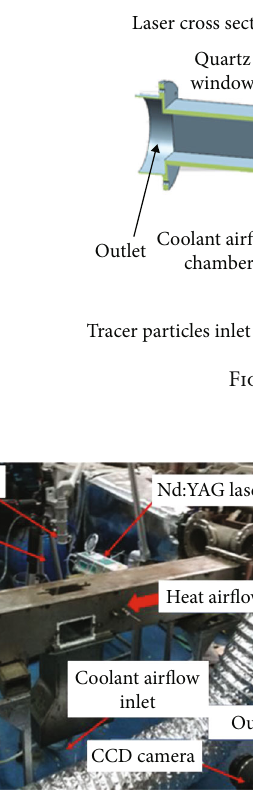
Figure 6: Physical picture of the PIV experimental